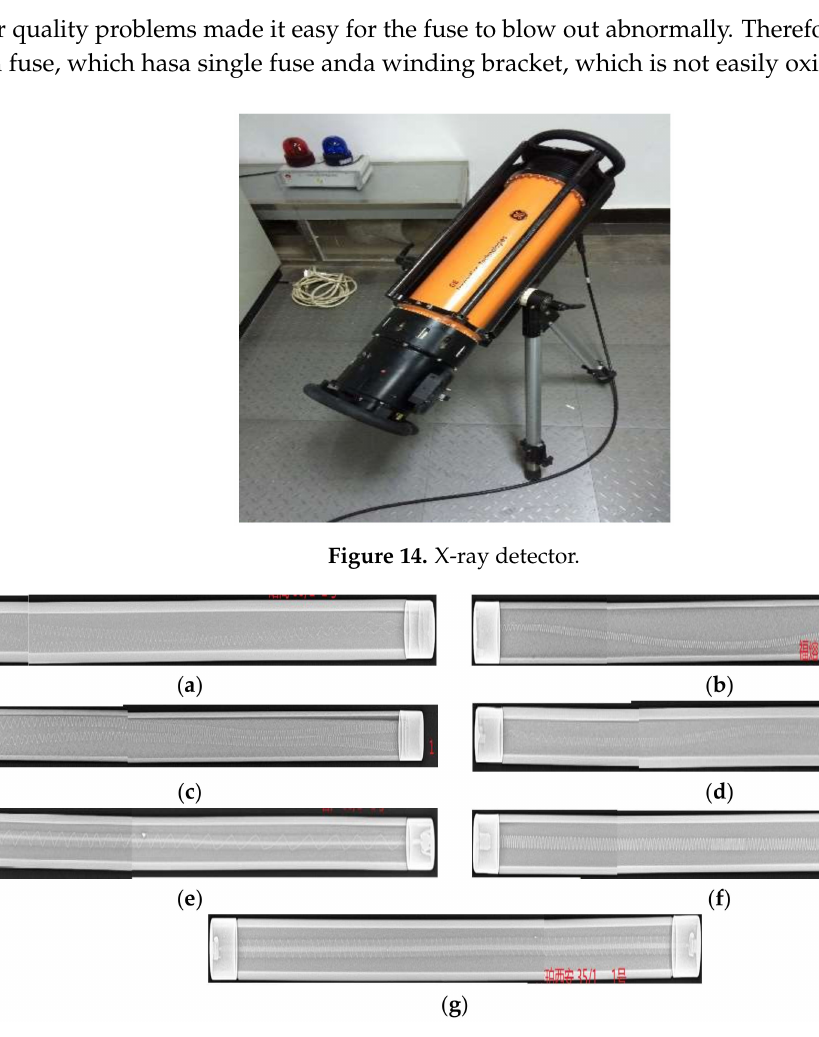
Figure 15. X-ray examination of fuses. ( a ) F 1 35 kV/2 A; ( b ) F 2 35 kV/2 A; ( c ) F 3 35 kV/2 A; ( d ) F 4 35 kV/2 A; ( e ) F 5 35 kV/2 A; ( f ) F 6 35 kV/2 A; ( g ) F 7 35 kV/2